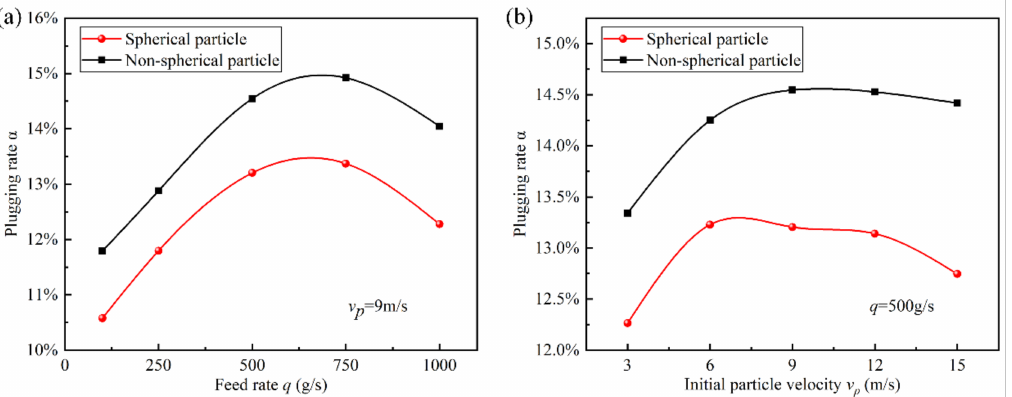
Figure 13. The effect of working parameters on plugging rate: ( a ) feed rate ( b ) initial particle